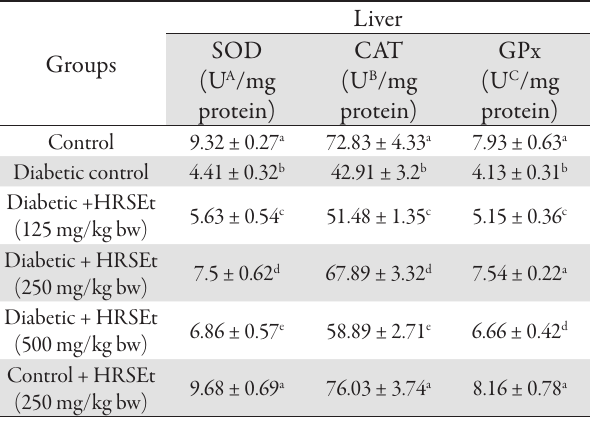
Tab. 7. Effect of HRSEt on the activities of enzymatic antioxidants